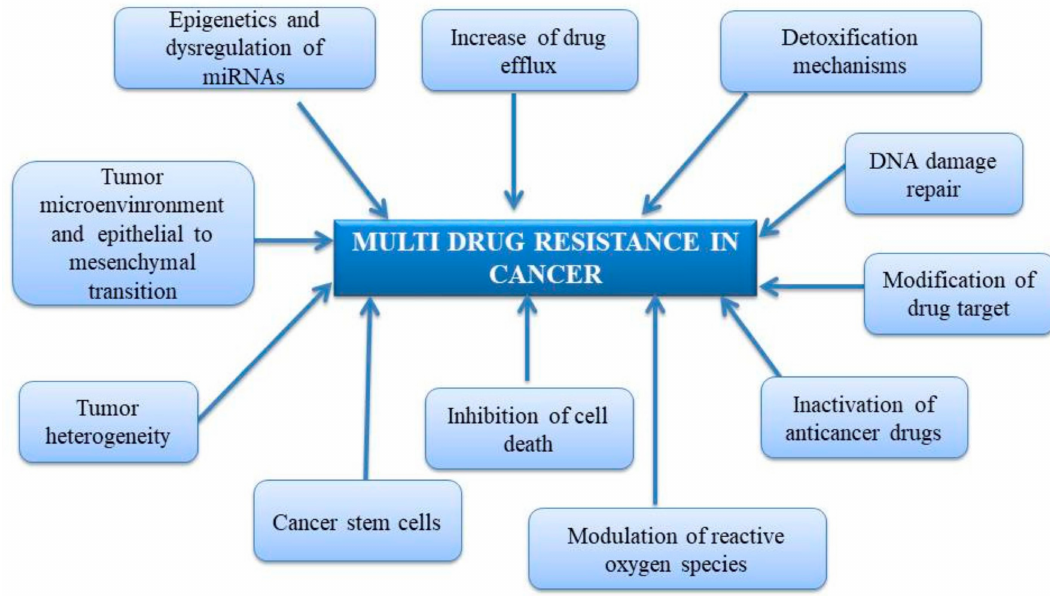
Figure 1. Mechanisms of multidrug resistance in